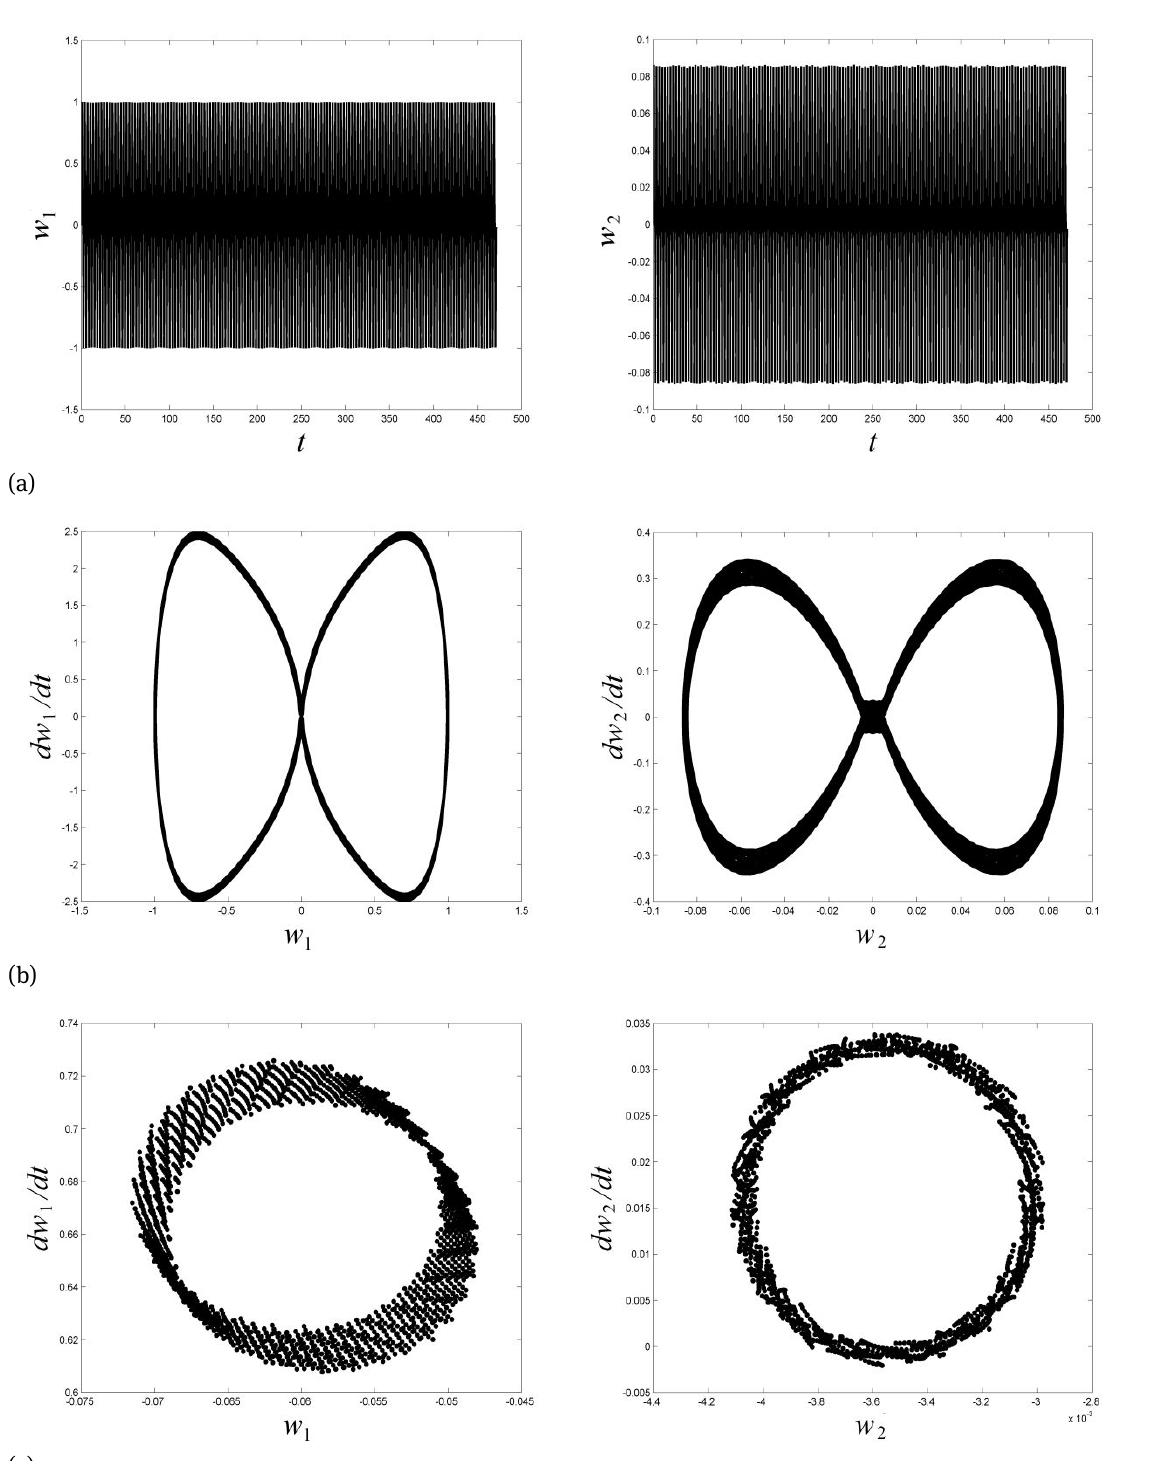
Fig. 4. Quasiperiodic behaviors of the cantilever beam system shown in wave diagrams (a), phase diagrams (b) and Poincaré maps (c). q